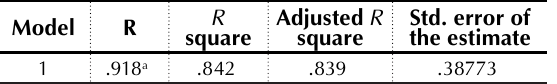
Table 12. ANOVA a